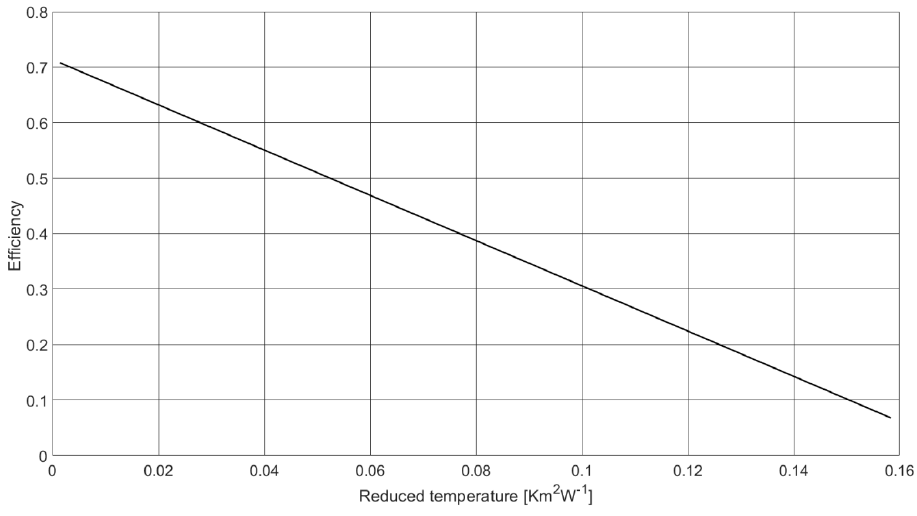
Figure 11. Efficiency characteristics of the collector determined using the ETN method. Figure 11. E ffi ciency characteristics of the collector determined using the ETN